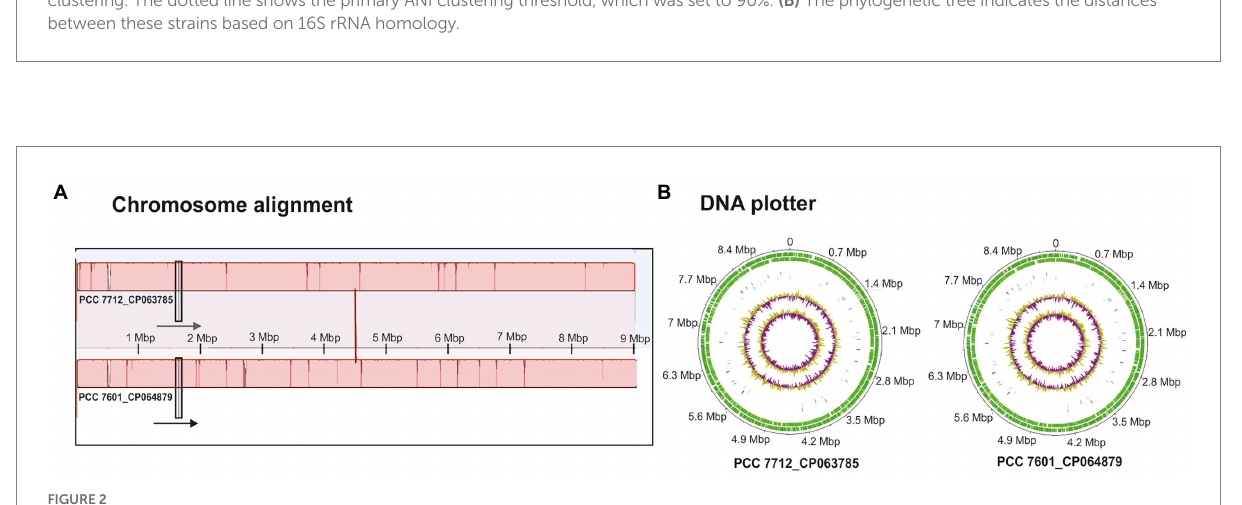
FIGURE 2 (A) Chromosome alignment together with the direction of sequences (arrows) and (B) DNA plotters of the two chromosomes of Tolypothrix sp. PCC 7712 and PCC 7601 showing GC and GC skew in the middle followed by RNAs (blue and red lines), and the outer line shows the sequence itself with its complementary strand